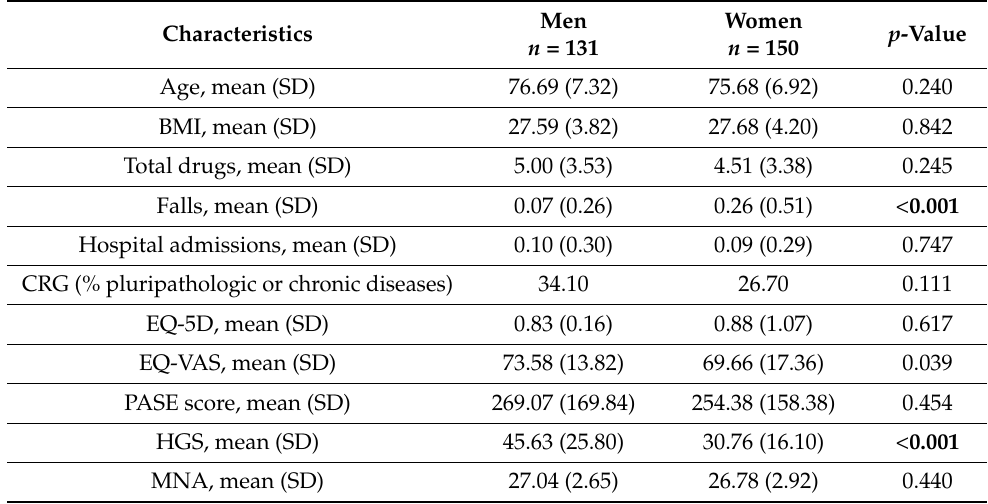
Table 1. Characteristics of the Study Participants (N = 281).